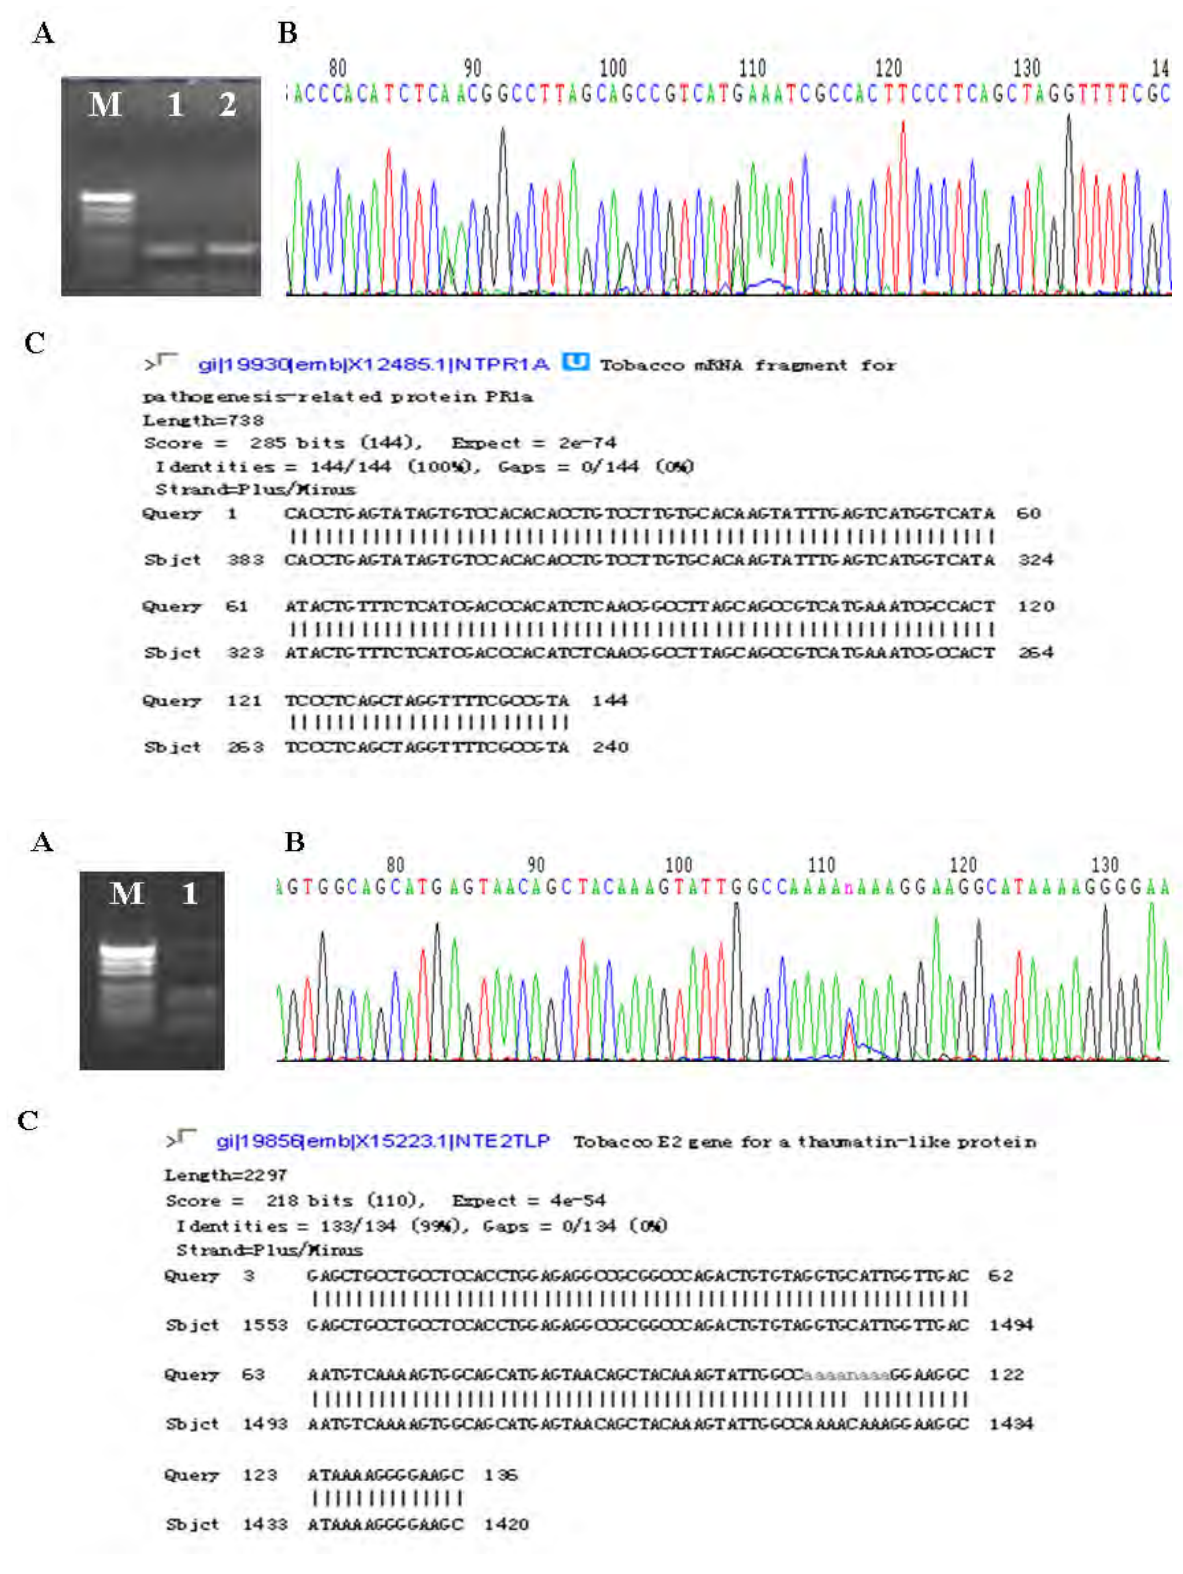
Figure 3. The clone of PR-1a and PR-5